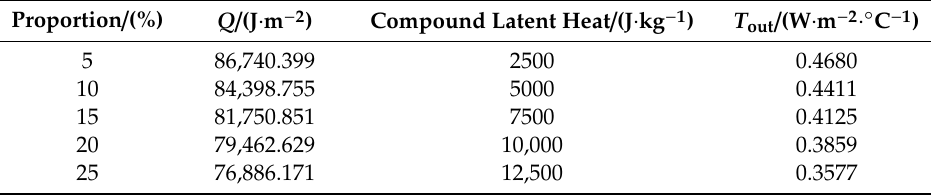
Table 4. Statistical results of di ff erent low temperature phase change